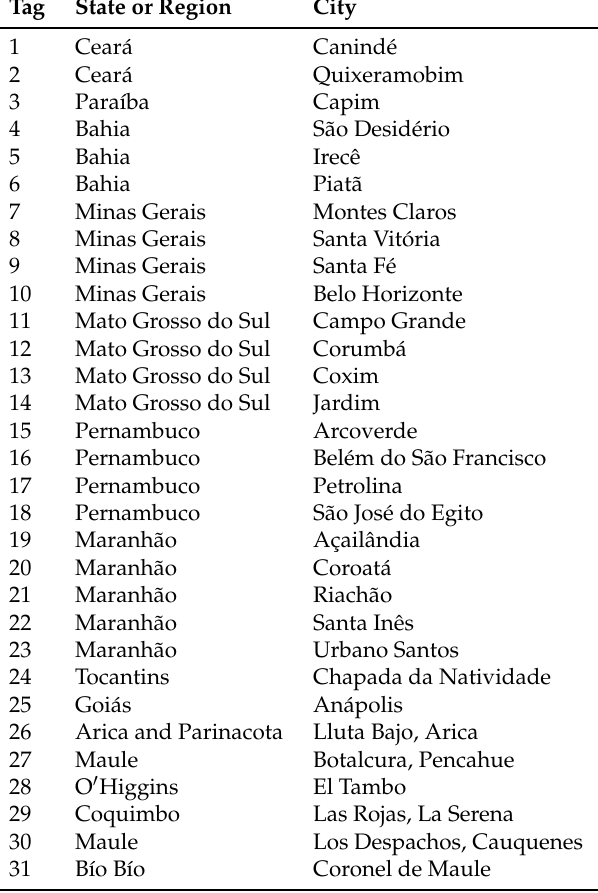
Table 1. Cities of the weather stations where the analyzed data were collected. Tagged cities from 1 to 25 are inside Brazil, and those from 26 to 31 are inside